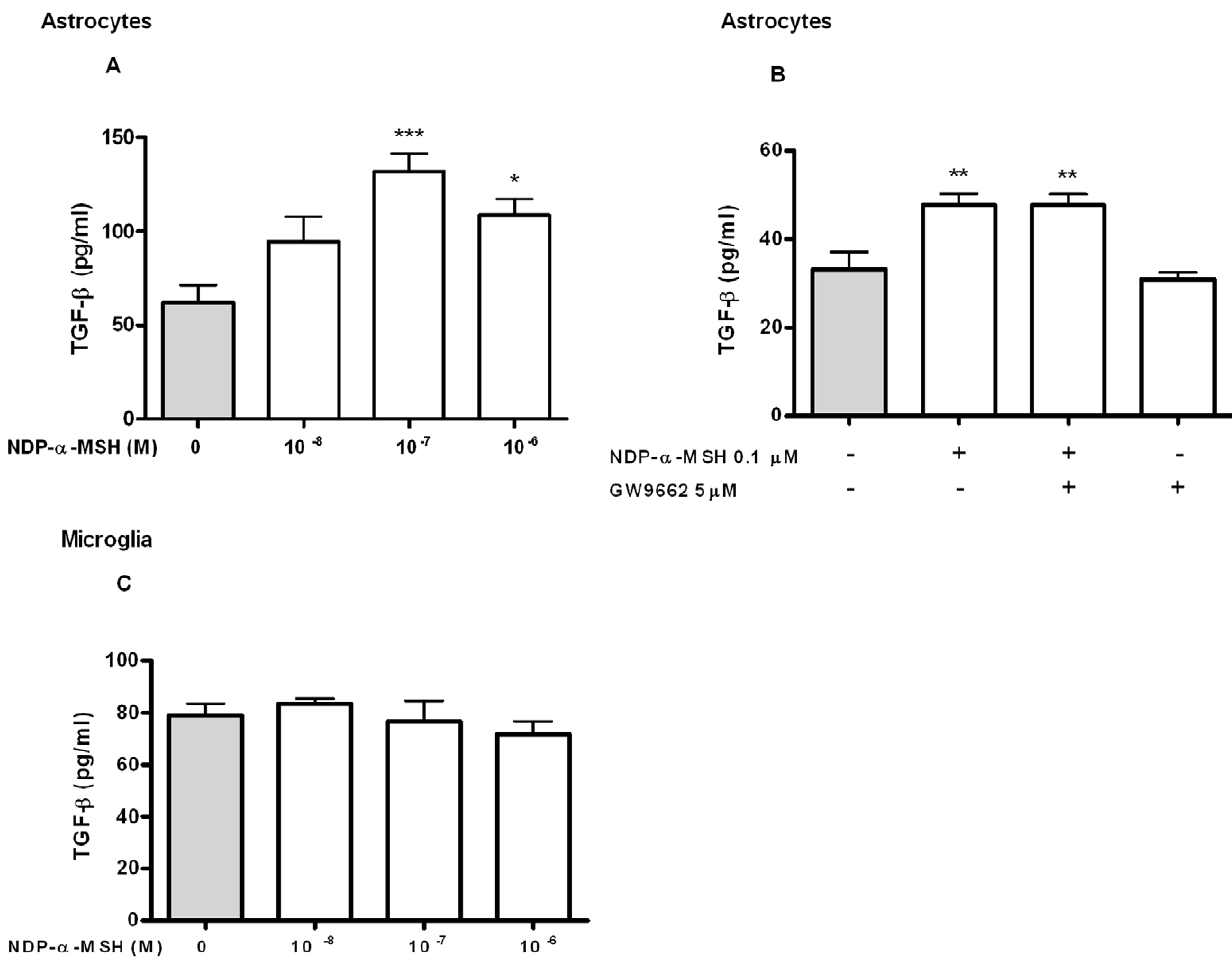
Figure 6. TGF- b release from rat astrocytes. TGF- b levels in culture supernatants were quantified by ELISA after 6 h of treatment. (A) NDP- a -MSH induced TGF- b release from astrocytes. (B) Treatment with 5 m M GW9662 had no effect on NDP- a -MSH-induced TGF- b release. (C) NDP- a -MSH had no effect on TGF- b release from microglia. Data were analyzed by one way ANOVA and are expressed as mean 6 SEM. *** p , 0.001, ** p , 0.01, * p , 0.05 vs. control group.